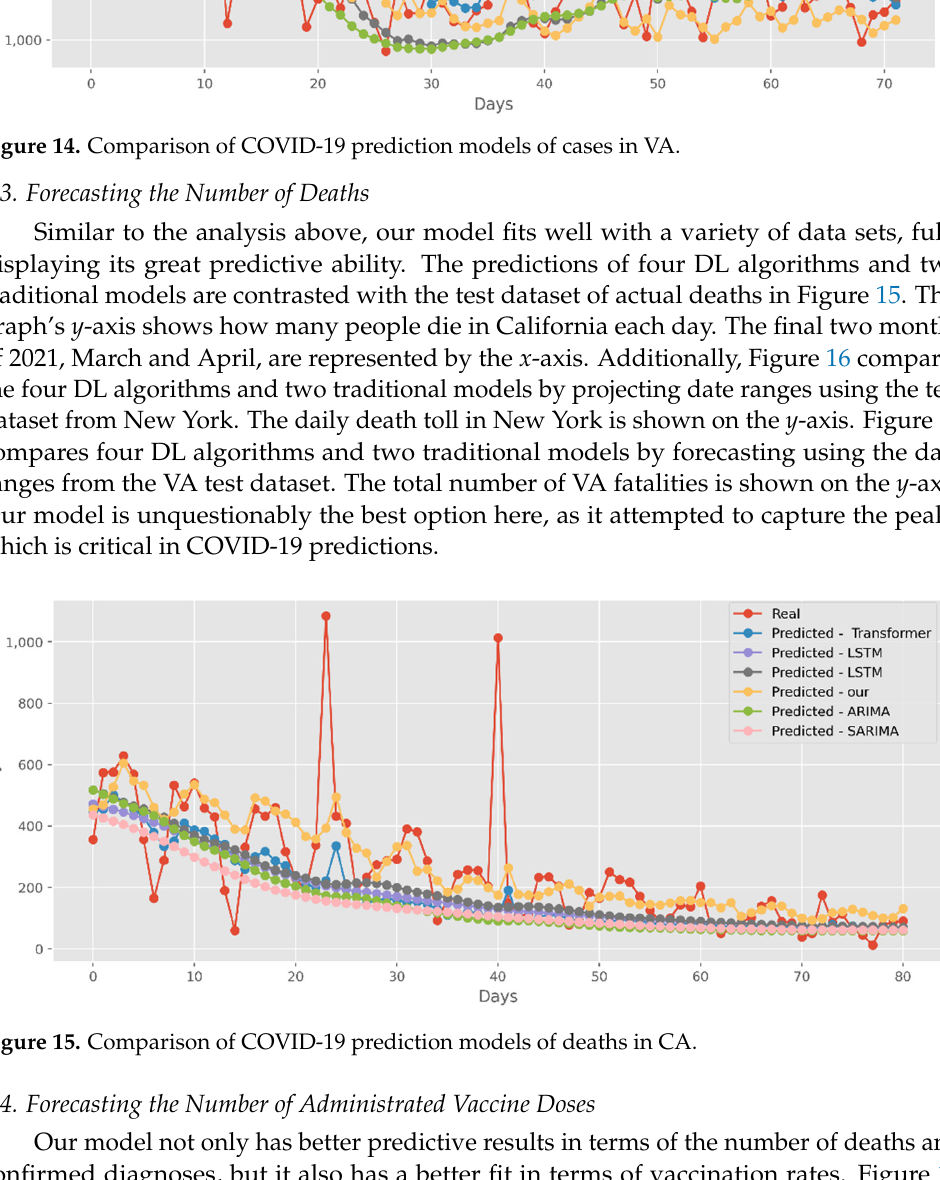
Figure 14. Comparison of COVID ‐ 19 prediction models of cases in VA.